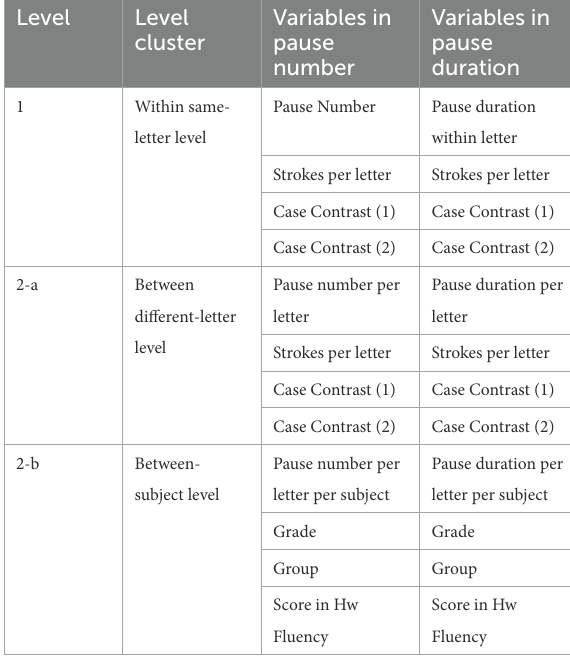
TABLE 4 Multilevel diagram in table